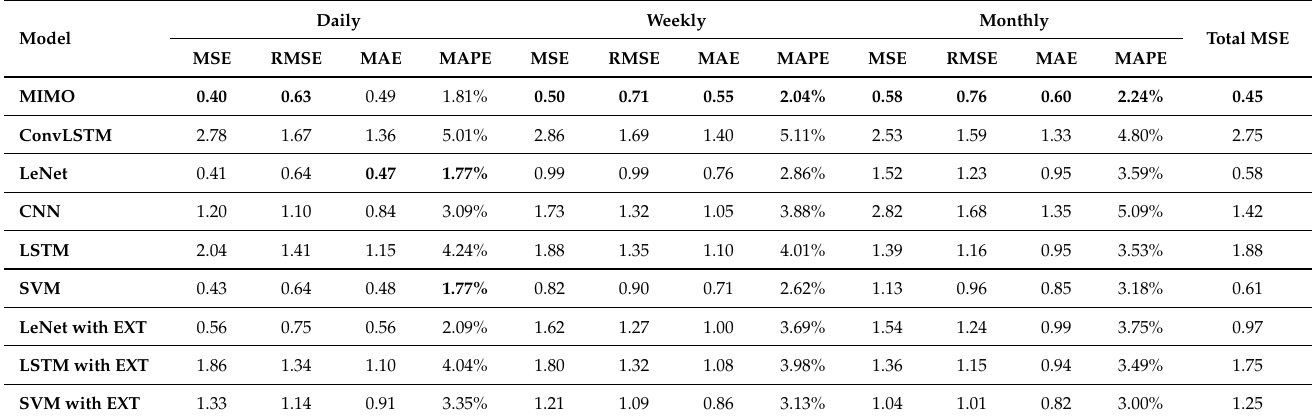
Table 2. The results of different SST prediction